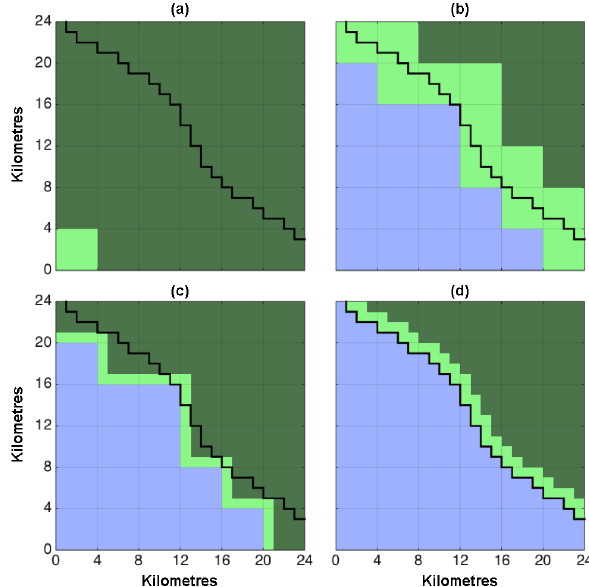
Figure 2. An illustration of the low-resolution block inspection im- provement upon the default flood-fill algorithm. Dark green: un- filled; light green: stack; blue: filled. Black line: shoreline at 1km resolution. (a) The 4km fill is given a seed in the southwest corner of the map. (b) The 4km fill is completed. (c) The 1km map and edge created from the intermediate 4km output. (d) The result of the 1km